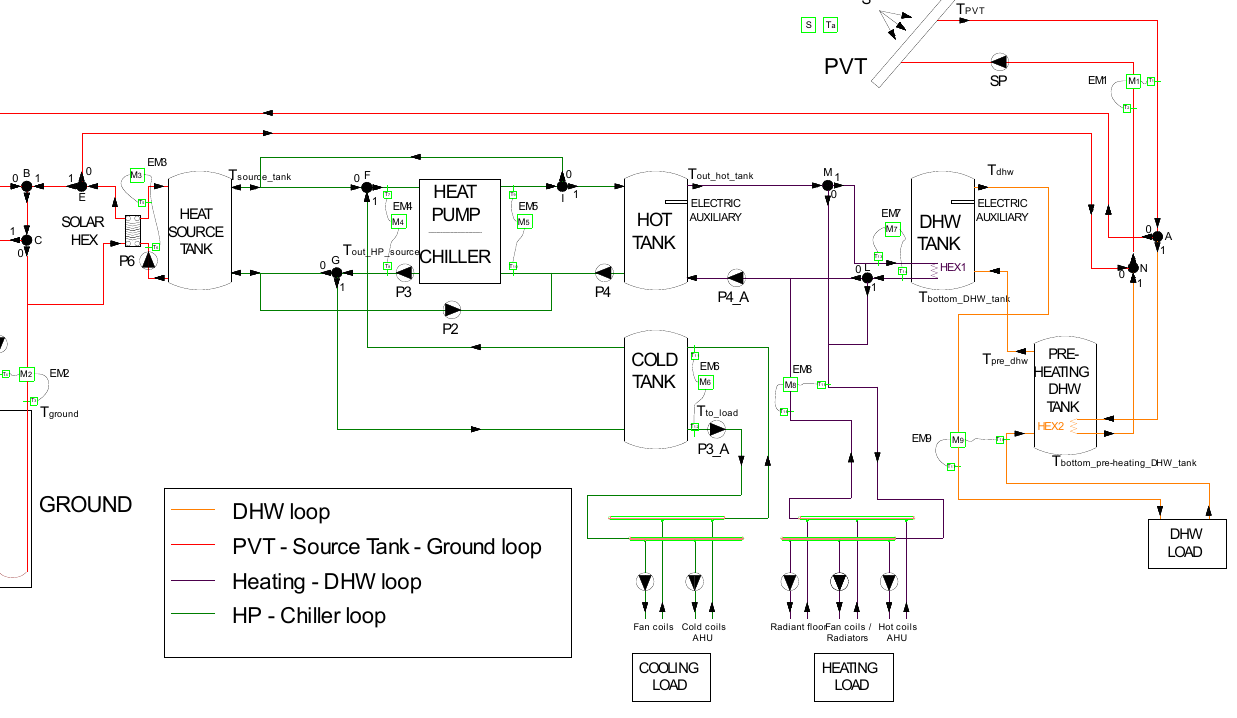
Figure 7. Simplified functional diagram of the HVAC plant.